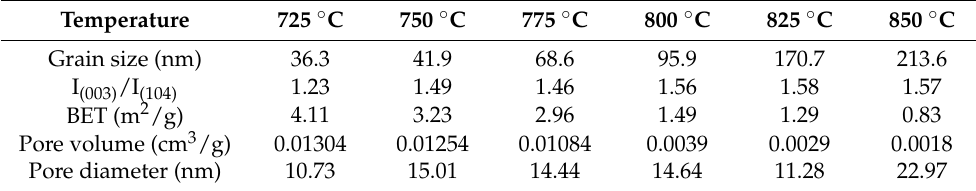
Table 1. Crystallographic data and BET surface area of SNCM cathodes.